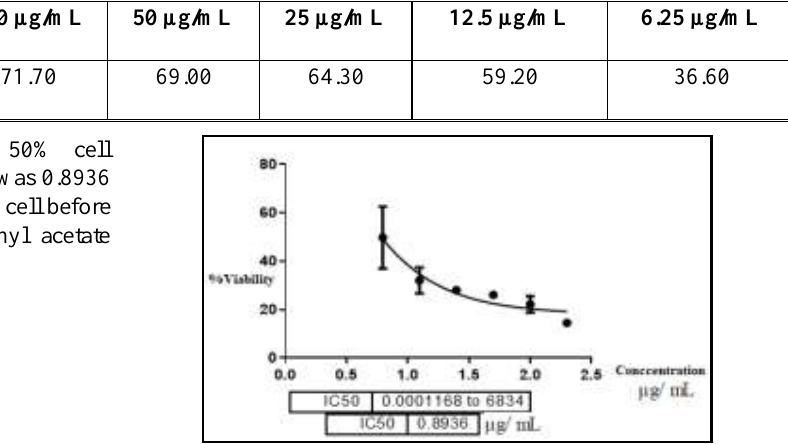
Figure 5. IC 50 of ethyl acetate fraction on AMJ13 cell